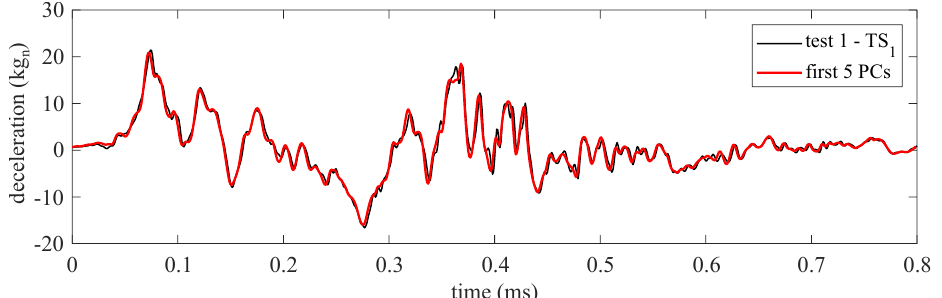
Figure 6. Comparison of the source domain measurements and its reconstruction using the first five PCs.